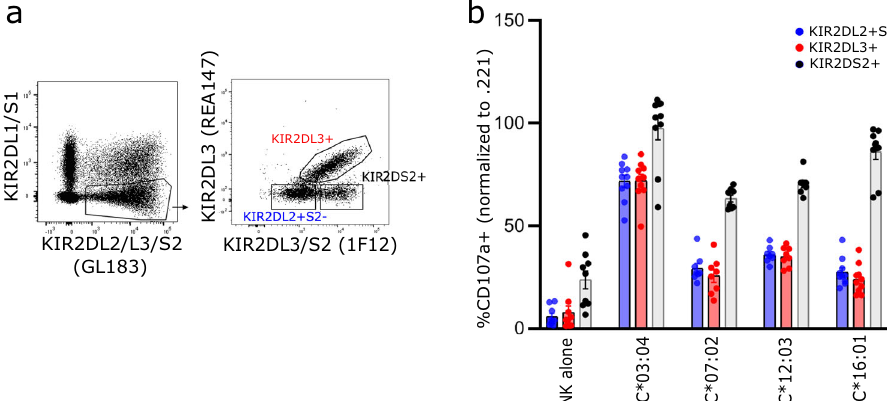
Fig. 6 The functional response of KIR2DL2 + S2 − and KIR2DL3 NK cells. a Flow cytometry pro fi le from one donor demonstrating gating strategy using 1F12 antibody. b Normalised responses of the gated populations following coculture either wild-type 221 cells or 221 cells transfected with HLA-C*03:04, -C*07:02, -C*12:03 or -C*16:01 is shown. Data are pooled from eight to ten donors from two experiments. Each symbol represents an individual donor and bars depict mean ± SEM